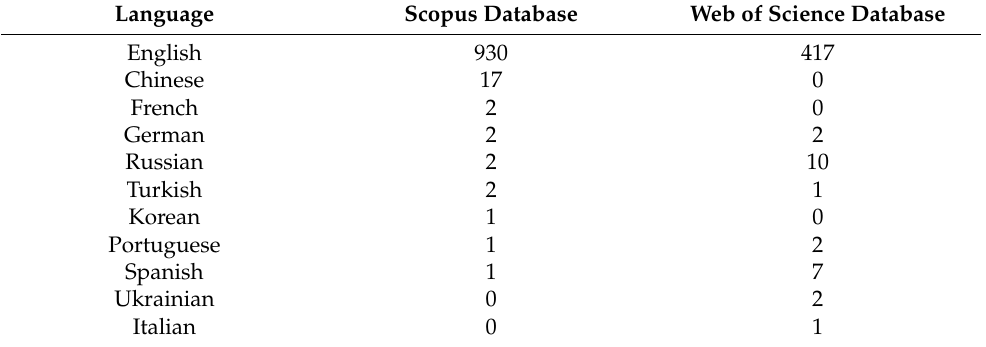
Table 4. Language trends of publication.